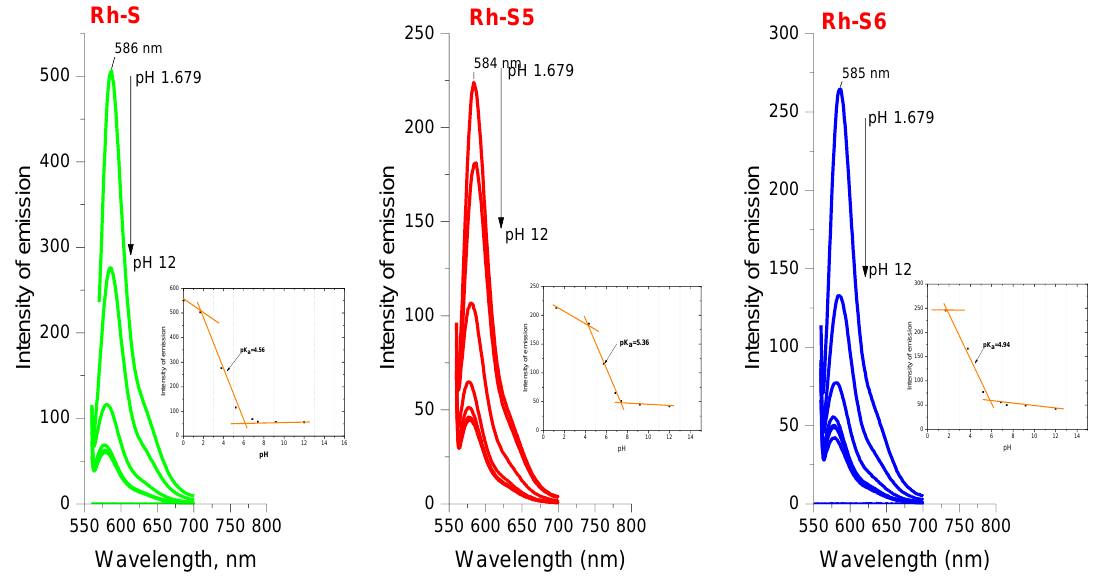
Figure 5. Emission spectra of spinorphin derivatives at λ ex = 560 nm and different pHs. The inset plots represent I(emission)/pH obtained from the emission spectra of the respective